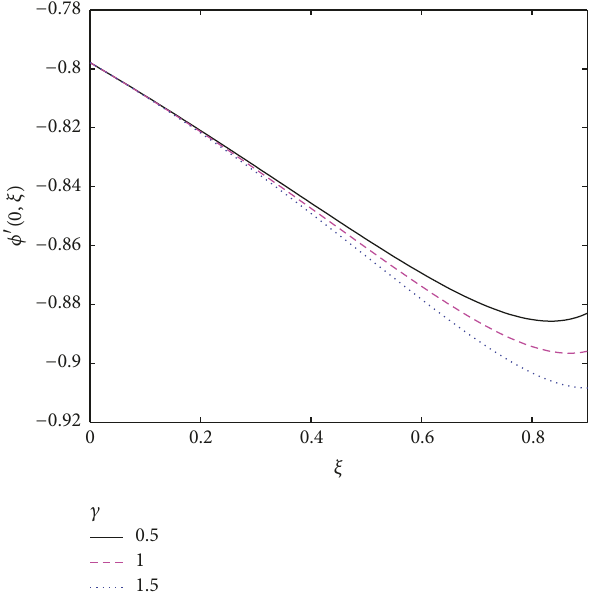
Figure 27: Effect of Pr on 𝜙 󸀠 (0, 𝜉) ( 𝜎 = 𝛾 = 0.5, 𝜆 = 1, Sc = 2, ℏ = −0.5